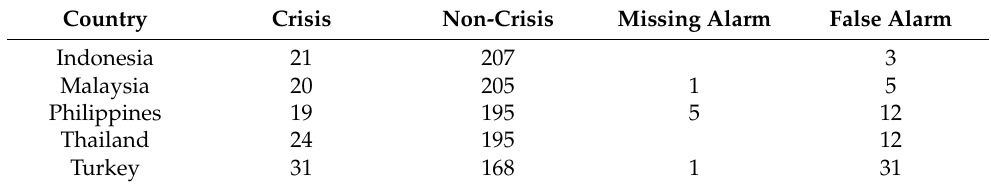
Table 9. Performance of EWS model in Asian countries with of cut-off = 13.27%. Country Crisis Non-Crisis Missing Alarm False Alarm